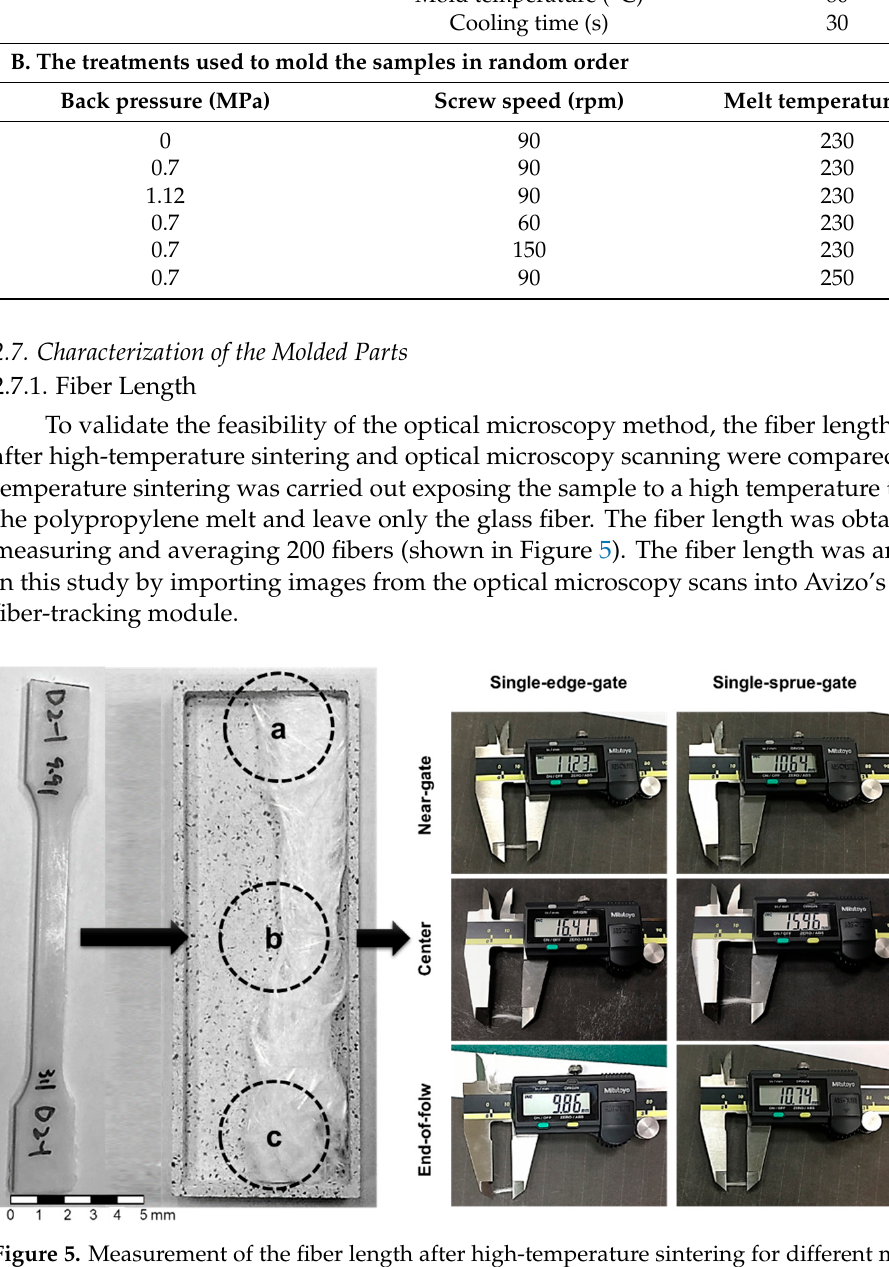
Figure 5. Measurement of the fiber length after high-temperature sintering for different melt flow paths: ( a ) the near-gate region, ( b ) the center region, and ( c ) the end-of-flow region.